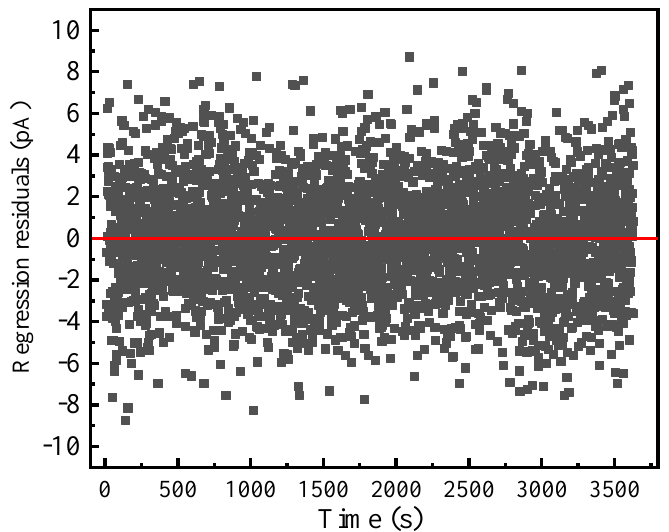
Figure 10. Relationship between residual values of original MgO powder and time obtained by (4) with l = 3 at 25 °C.